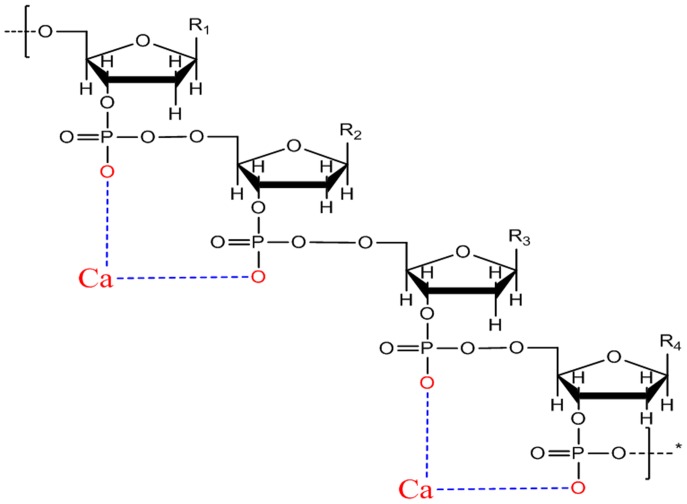
Molecular model combining the –POO–– group of DNA with Ca2+ linked by an electrovalent bond.R1, R2, R3, and R4 represent the different bases in DNA, and the blue dashed line represents the electrovalent bond between Ca2+ and the –POO–– group.